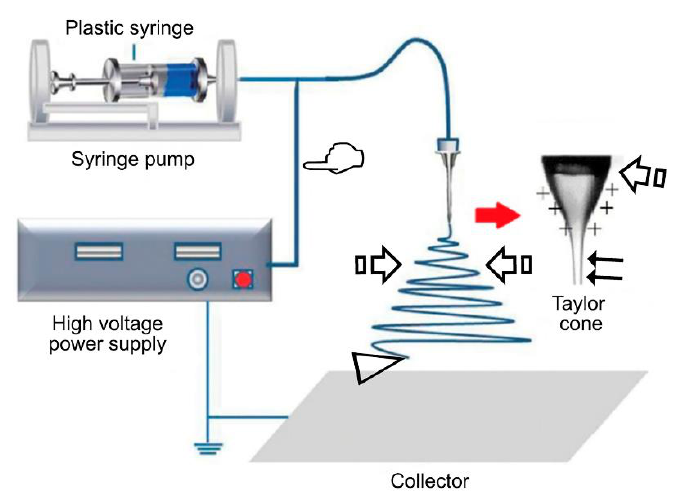
Figure 1. This technique begins with the application of a high potential (14–16 kV) between the metal collector, located at a predetermined distance from the tip of the needle tip, and the polymer solution droplet in the syringe (pointer). The electrostatic force turns the drop into a hemispherical form, which is known as the Taylor cone (arrow). When the electrostatic potential difference is high enough to overcome the surface tension of the polymer drop located at the tip of the metal needle, an elongated cone is generated. This results in the production of a charged liquid jet from the Taylor cone, which is able to travel through a linear distance [generally 1–2 cm, known as the jet length (double arrows)]. The charged liquid jet is submitted to whipping instabilities. These alterations cause the jet to acquire a longer and thinner form due to the plastic deformation, stretching its length thousands of times its original size. The plastic deformation tends to dry the jet, and it results in ultrafine fibers before their arrival to the metallic collector (faced arrows). The solvents are evaporated on the way from the needle to the collector (arrow head) [12,15,18,19]. Figure reproduced and adapted from Chen et al. (2019) [20]. Copyright MDPI, 2019.